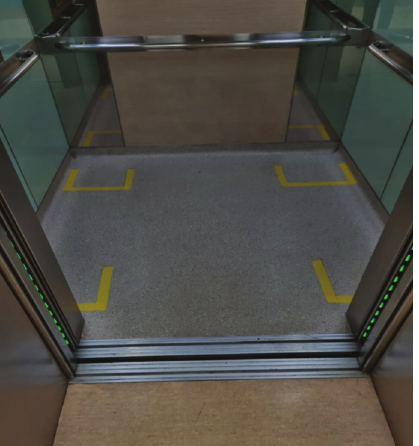
COVID-19 timeline and progress in Singapore. Fig. 1: